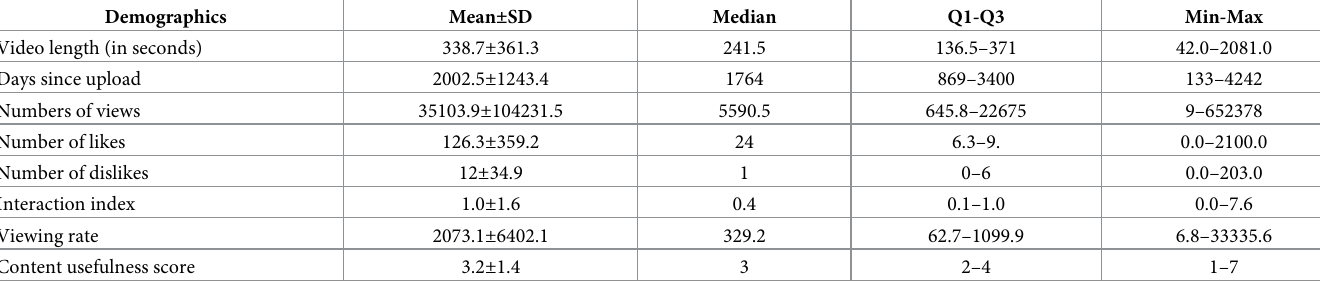
Table 3. Descriptive statistics of evaluated videos (n = 42).